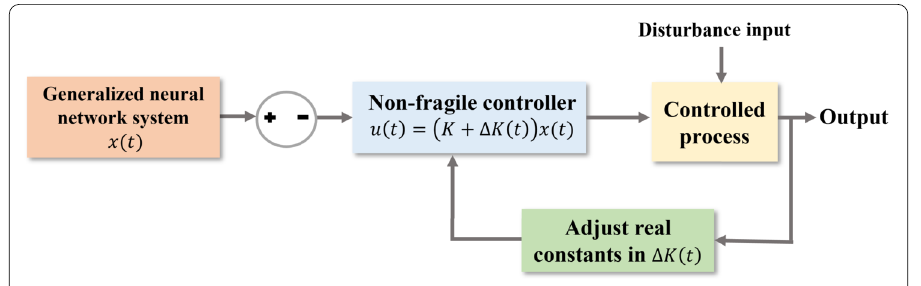
Figure 1 Systematic diagram of the nonfragile